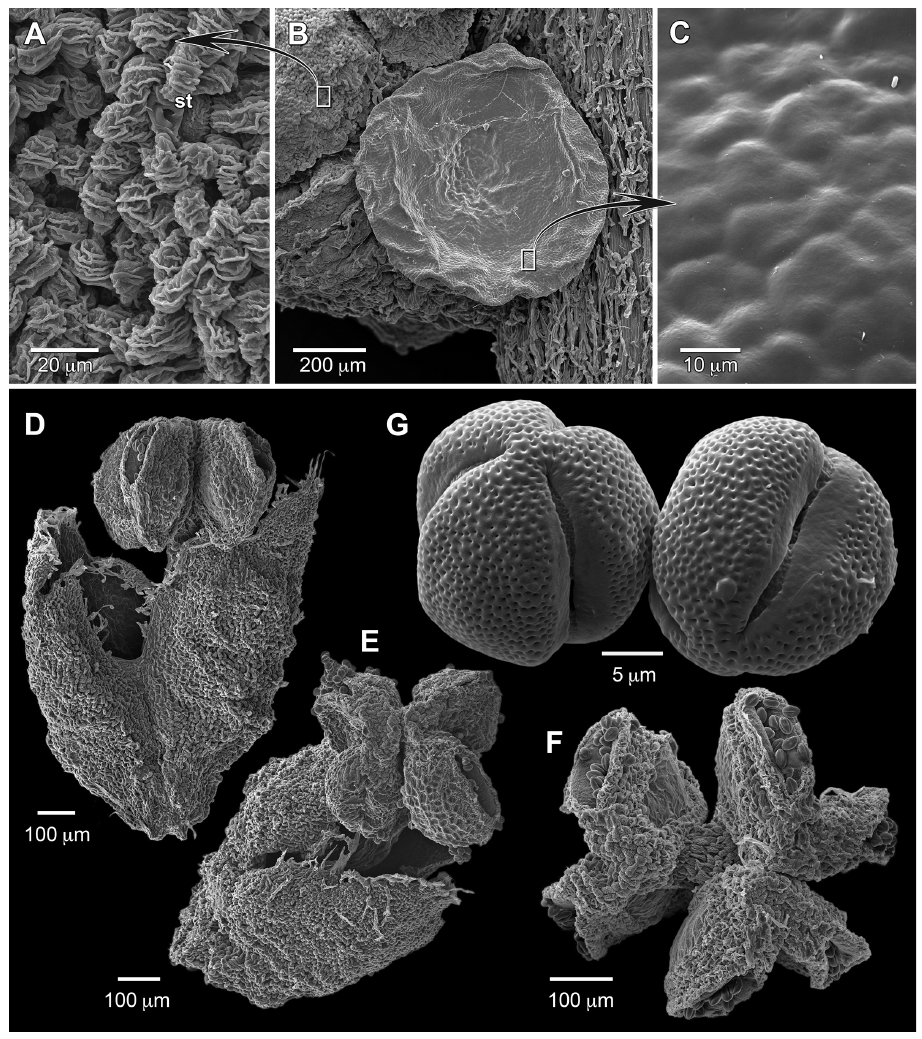
Figure 4. Floral morphology of Dendrothrix condorensis . A Staminate sepal outer surface showing papil- lae and stomata (st) B Staminate cymule base showing subtending discoid gland C Surface of staminate cymule gland D Staminate flower E Staminate flower F Triandrous flower, top view of slightly asymmetri- cally fused androecium G Pollen. (Source: SEM of Neill & Quizhpe 14939 ,